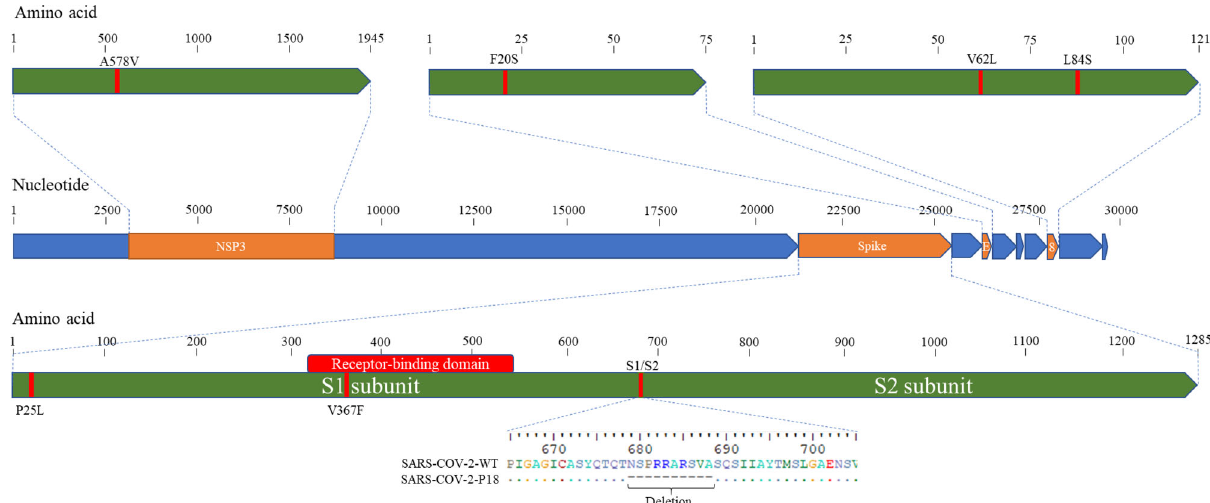
Fig. 1 Schematic diagram of the SARS-CoV-2 genome showing the deletion and mutations of Ca-DelMut. Del-Mut-1 virus 18 was serially passaged in Vero E6 cells at 33 °C (10 passages) and 30 °C (8 passages). Virus from the 18th passage was designated as Ca-DelMut live attenuated SARS-CoV-2 virus and ampli fi ed to prepare a virus stock. Ca-DelMut was sequenced by the Sanger method; mutations are shown in the diagram and in